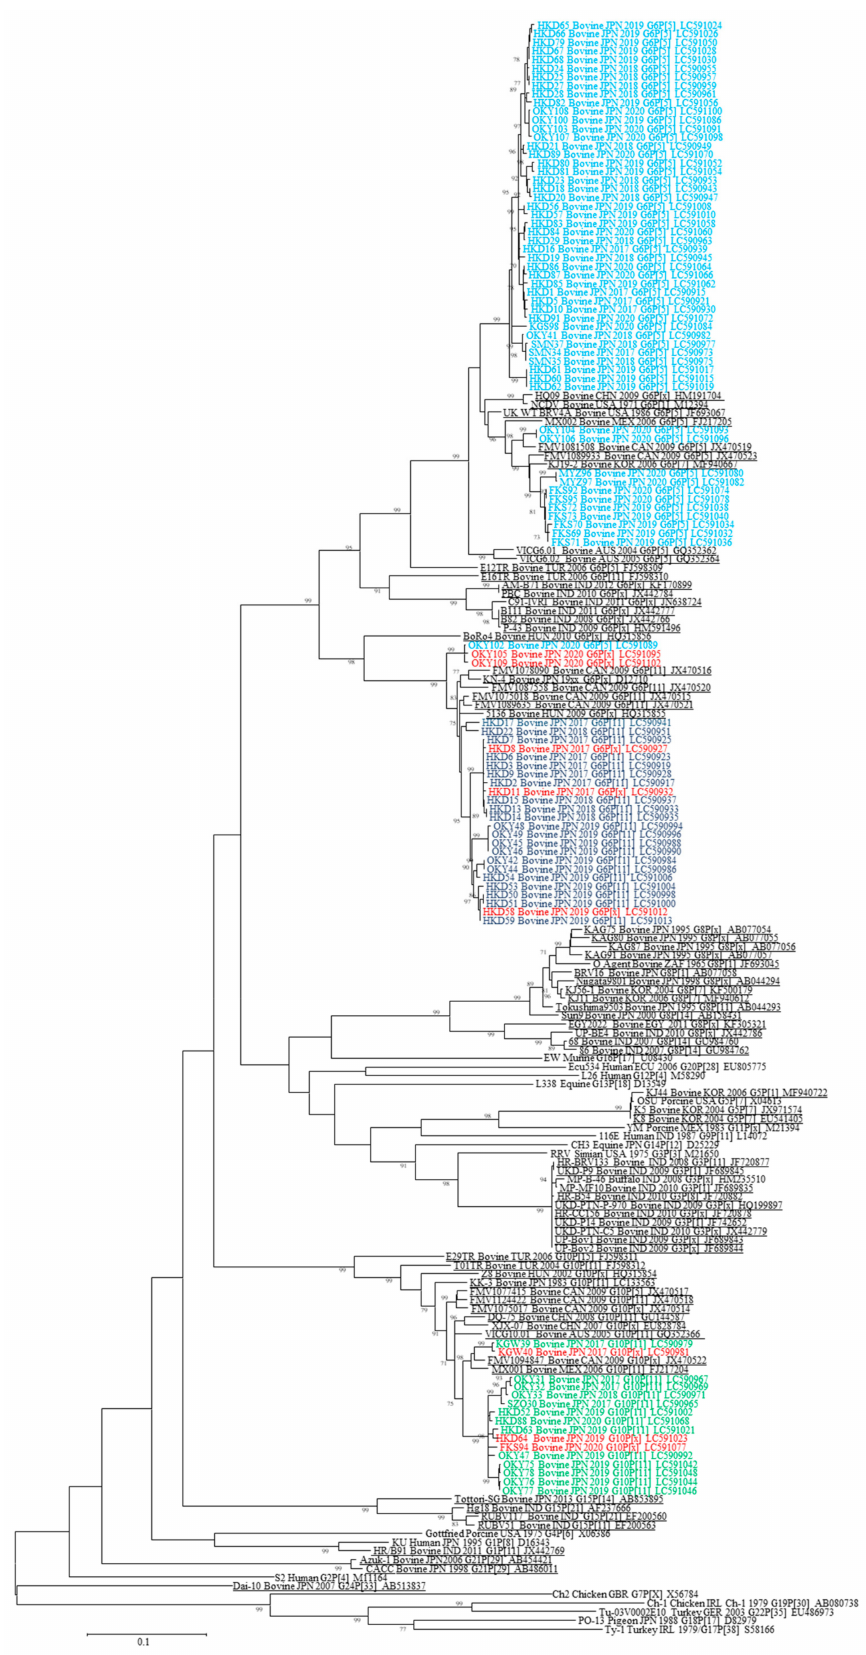
Figure 1. Phylogenetic tree based on the open reading frame (ORF) nucleotide sequences of rotavirus A (RVA) VP7. A phylogenetic tree was constructed using the maximum-likelihood method with